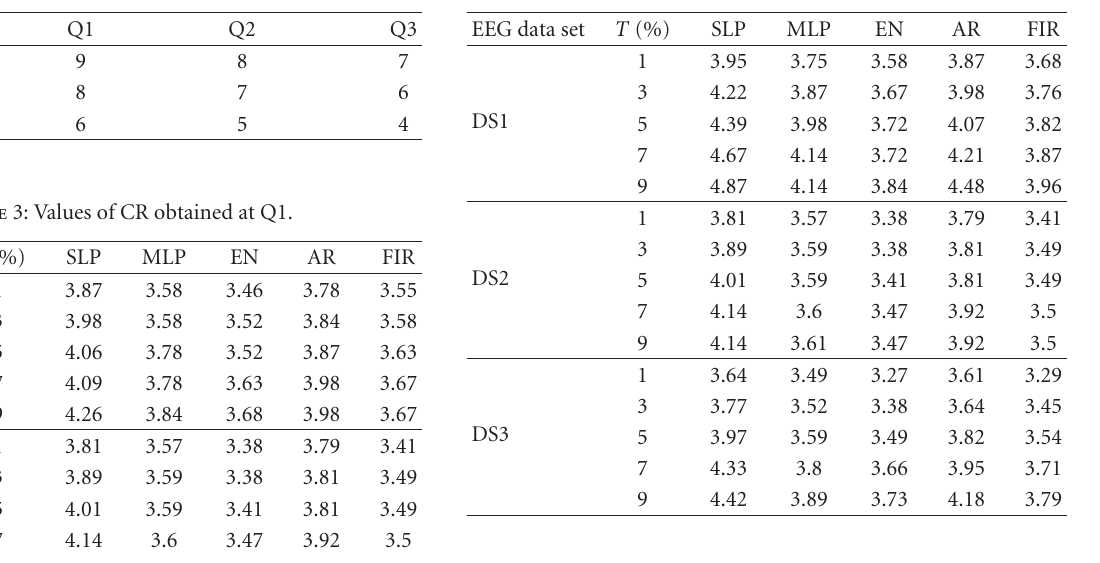
Table 2: Quantization level.